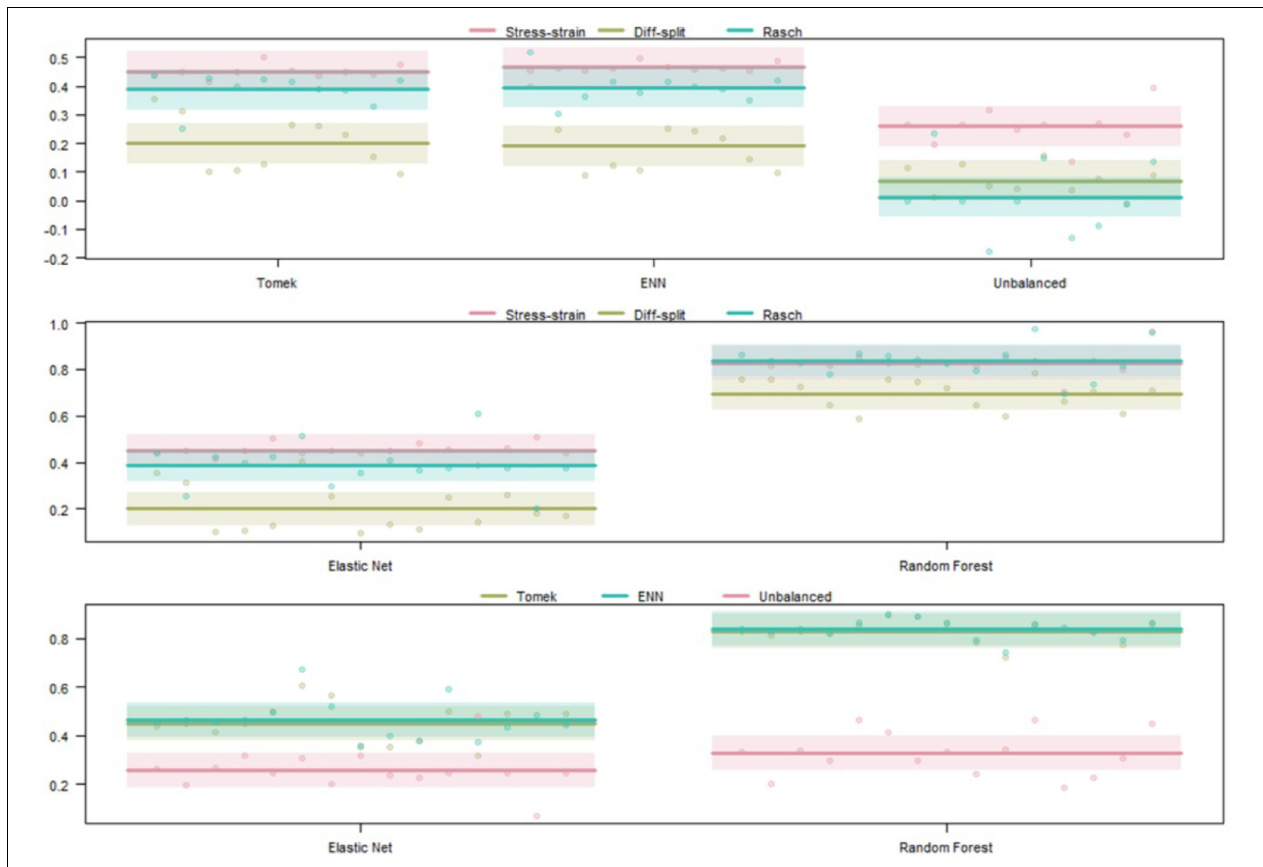
FIGURE 7 | Regression estimates for fivefold cross-validation on the WM task and various combinations of techniques. Points along the y -axis are GINI Index values for individual folds, lines are the regression estimate, and bars are the error of the estimate. (Top) Balancing techniques and labeling methods, (Middle) machine learning algorithms and labeling methods, and (Bottom) machine learning algorithms and balancing